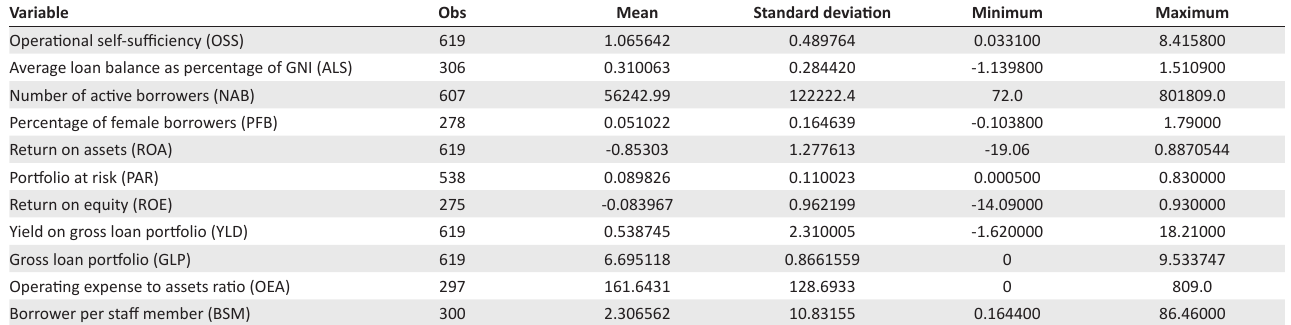
TABLE 1: Descriptive statistics of variables used in the study.